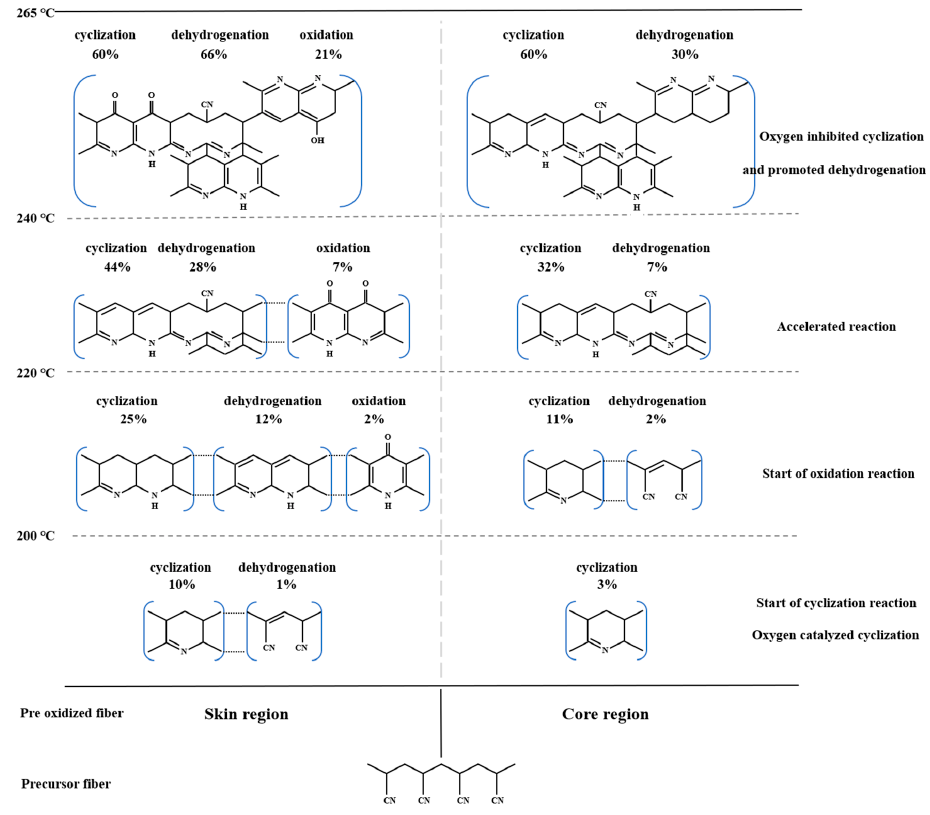
Figure 6. Schematic of the chemical evolution of the skin-core structure of PAN-based pre- oxidized